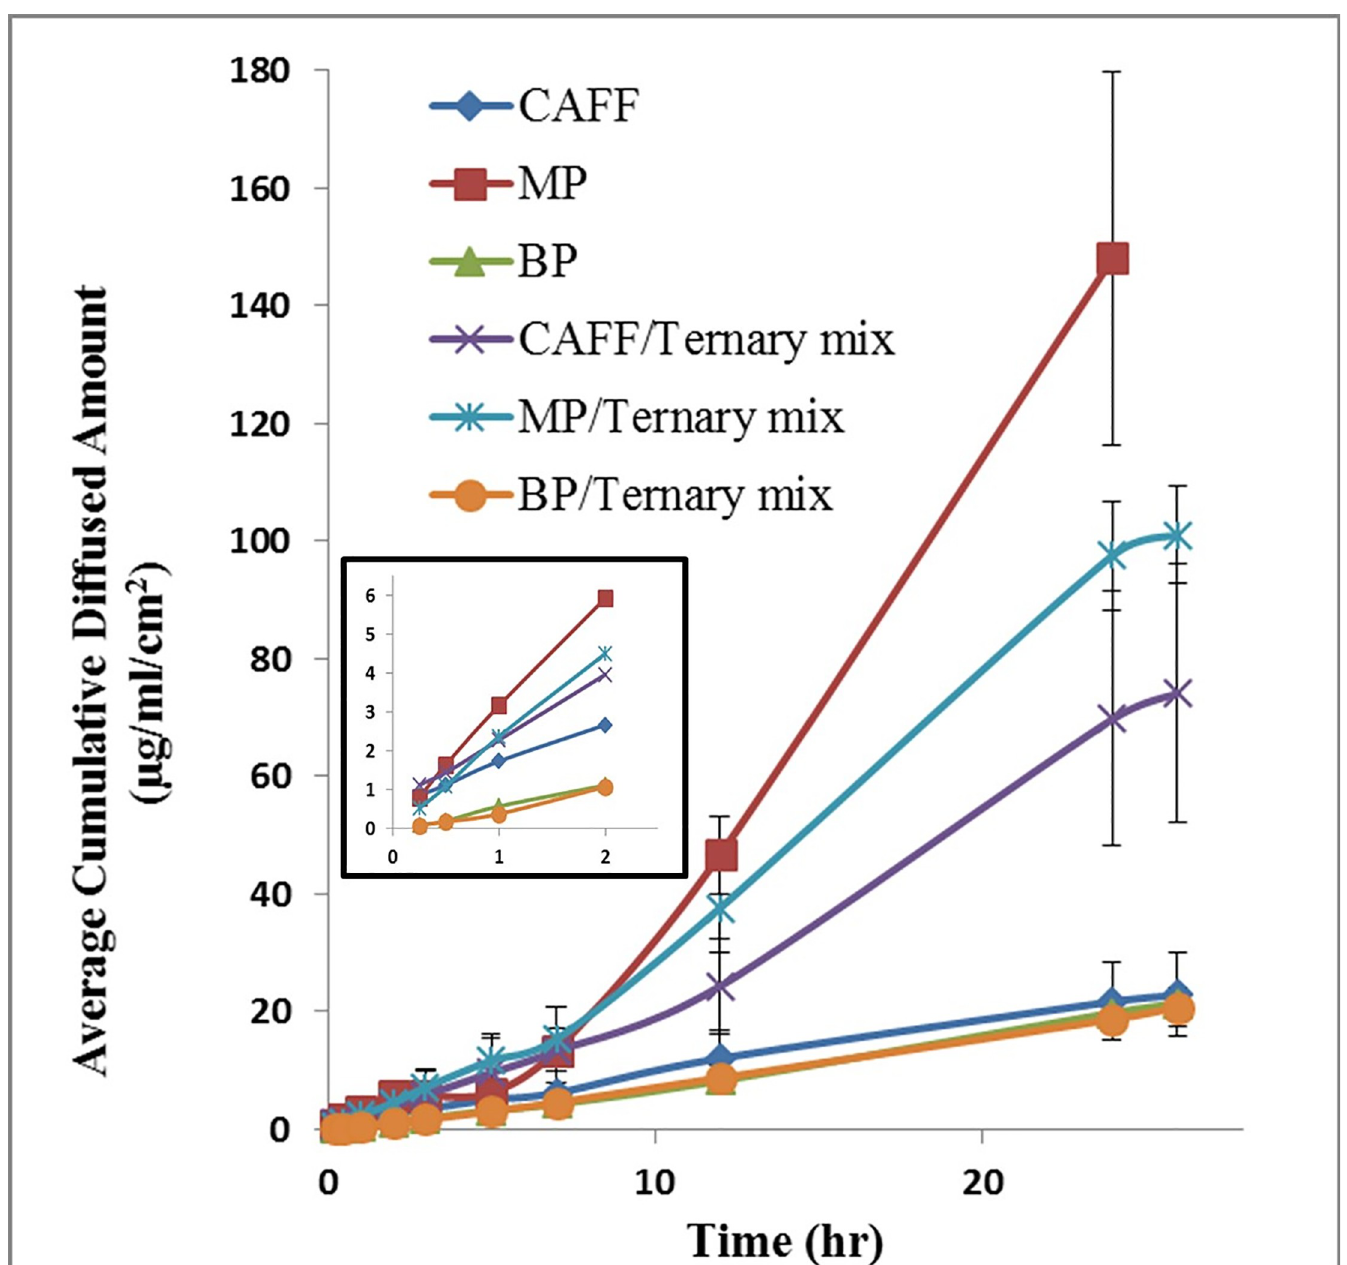
Fig 6. Diffusion profiles, through stratum corneum, of CAFF, MP and BP from their corresponding individual and ternary mixture emulgels. The plot in the insert shows the points obtained at the early stage of the experiment. n = 4–6.